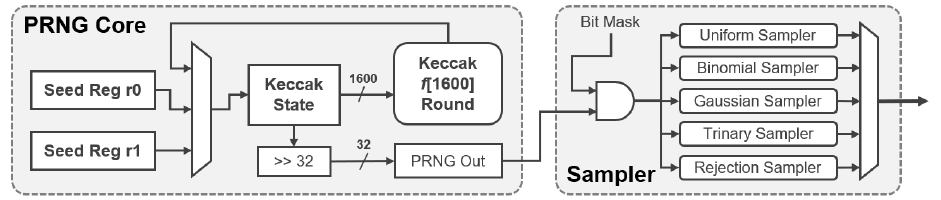
Figure 9: Architecture of discrete distribution sampler with Keccak-based PRNG